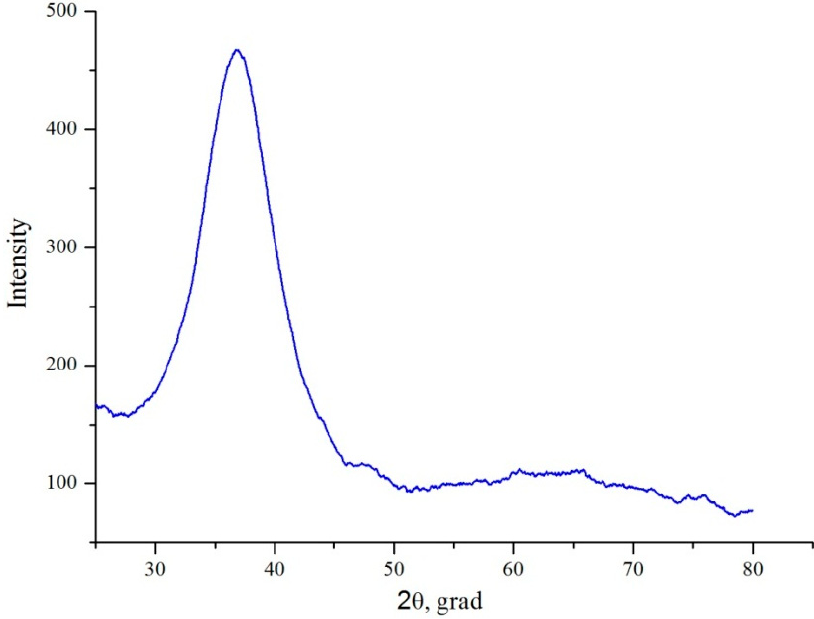
Figure 2. X-ray diffraction curve.